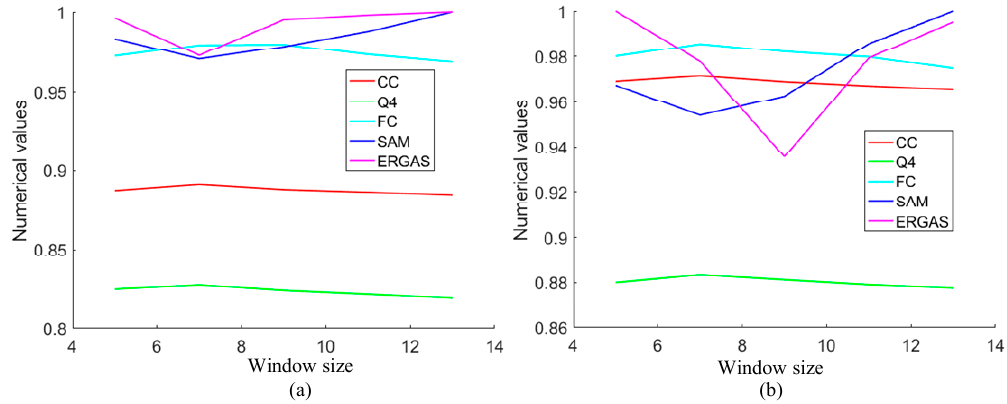
Figure 8. The variations of metrics with different window size. ( a ) Performance influence of window size on QuickBird datasets, ( b ) Performance influence of window size on Geoeye-1 datasets.